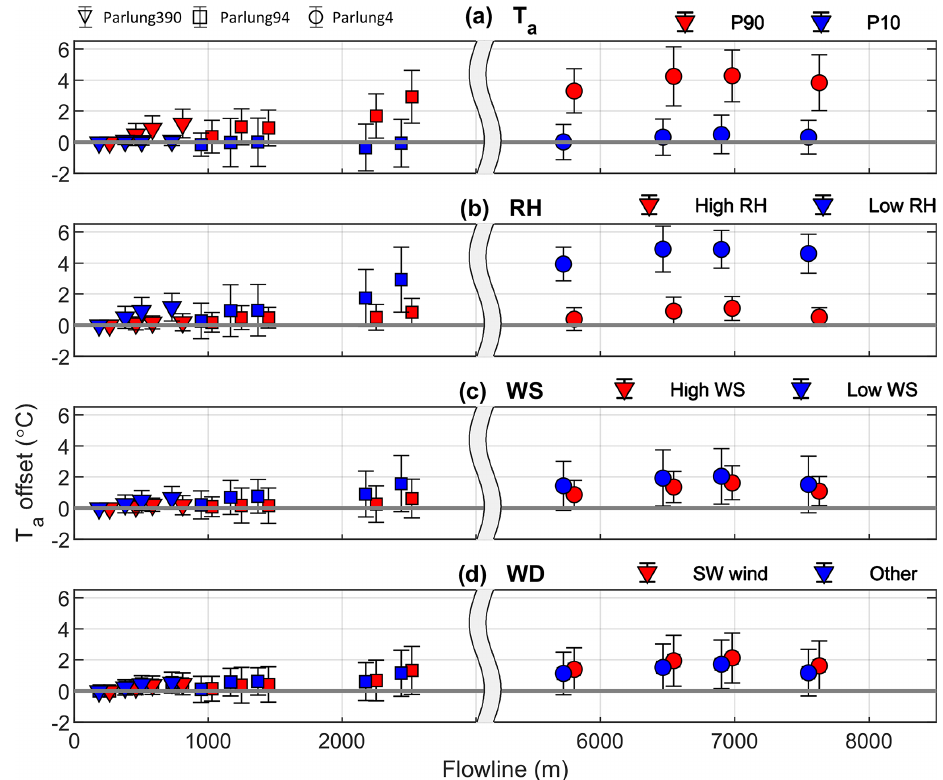
Figure 6. The mean and standard deviation (error bars) of hourly T a differences ( T a Amb – observed) along the glacier flowline. Each panel depicts hourly grouping by (a) off-glacier T a at AWS_Off (P90 is ≥ 10.5 ◦ C and P10 is ≤ 3 . 5 ◦ C), (b) off-glacier RH at AWS_Off (high is > 90% and low is < 70%), (c) wind speed from ERA5 (high is > 2 . 5ms − 1 and low is < 0 . 7ms − 1 ) and (d) dominant wind direction from ERA5 (south-west wind direction is considered as 180–270 ◦ ). Marker shapes show the different glaciers, as in Figs. 3 and 4. X axes are split to improve visibility at low flowline distances. Table 3. The coefficients of the original SM10 model and those fitted to the k 1 and k 2 sensitivities on the Parlung glaciers and all glaciers where no warming effect was evident (see Fig.